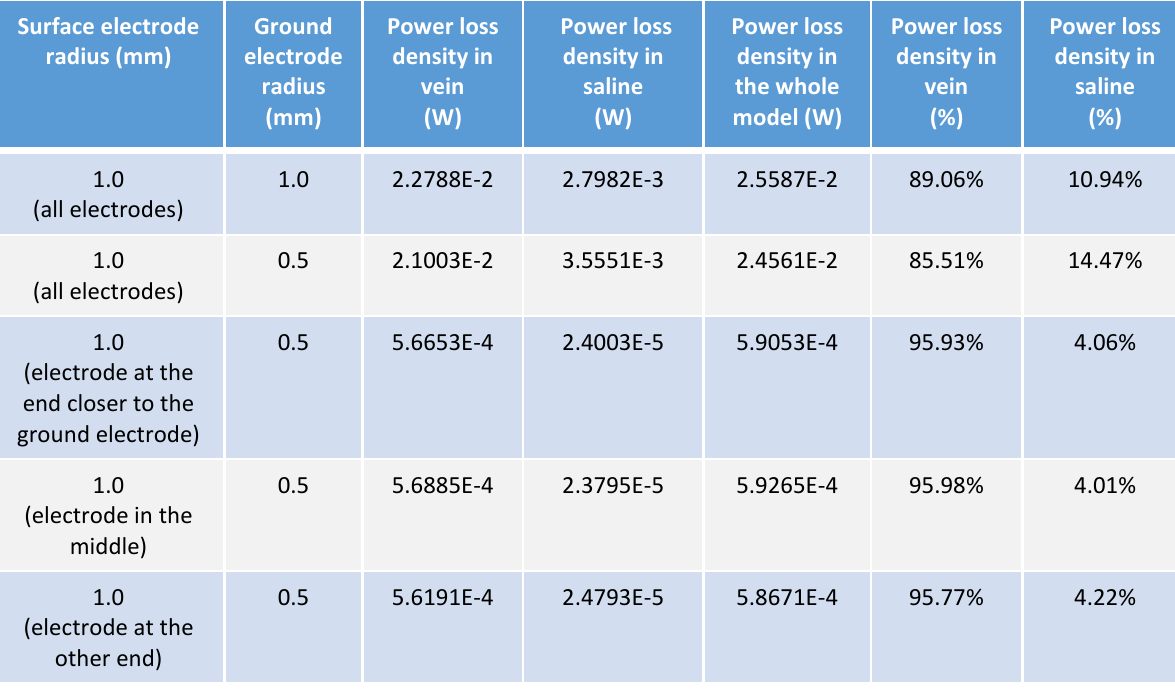
Table.17: Volumetric power loss density measurements at 1MHz with both all and one of the 48 surface electrodes as terminal (12 electrodes in 4 rows)